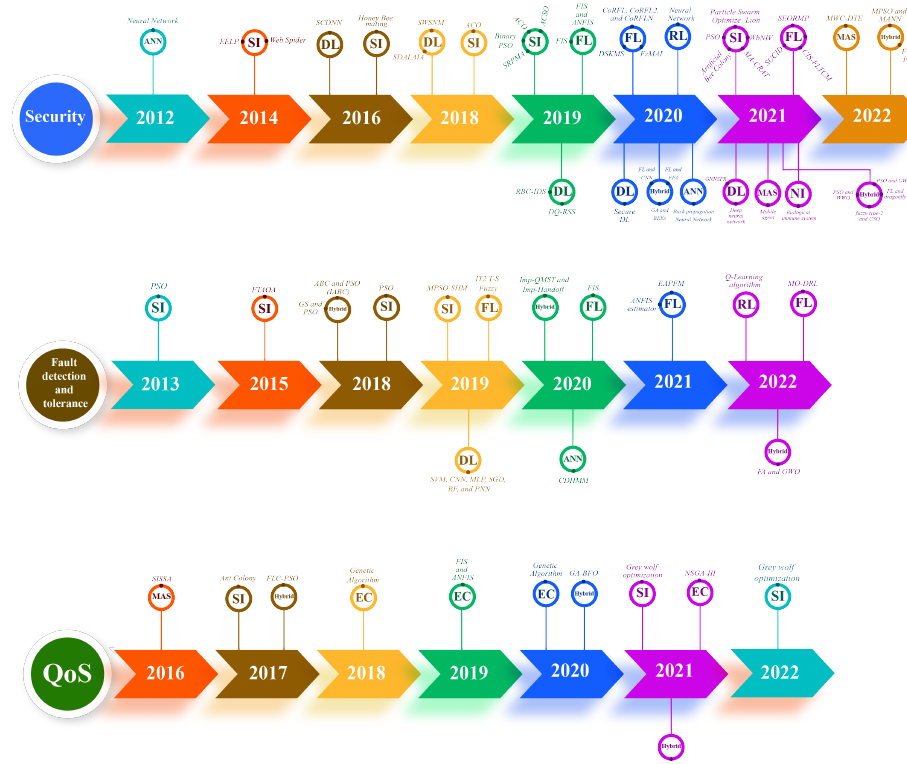
Figure 4. Diagram of route of technology development for each